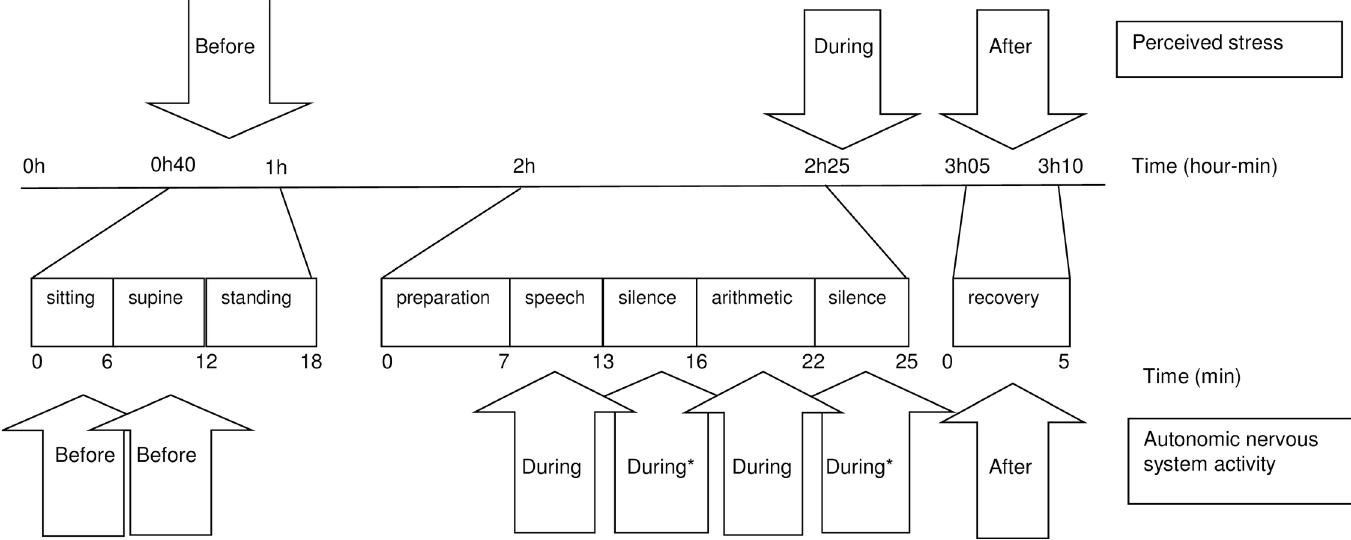
Fig 1. Timeline of the stress experiment and time points at which perceived stress and autonomic nervous system activity have been assessed. * used as robustness check.